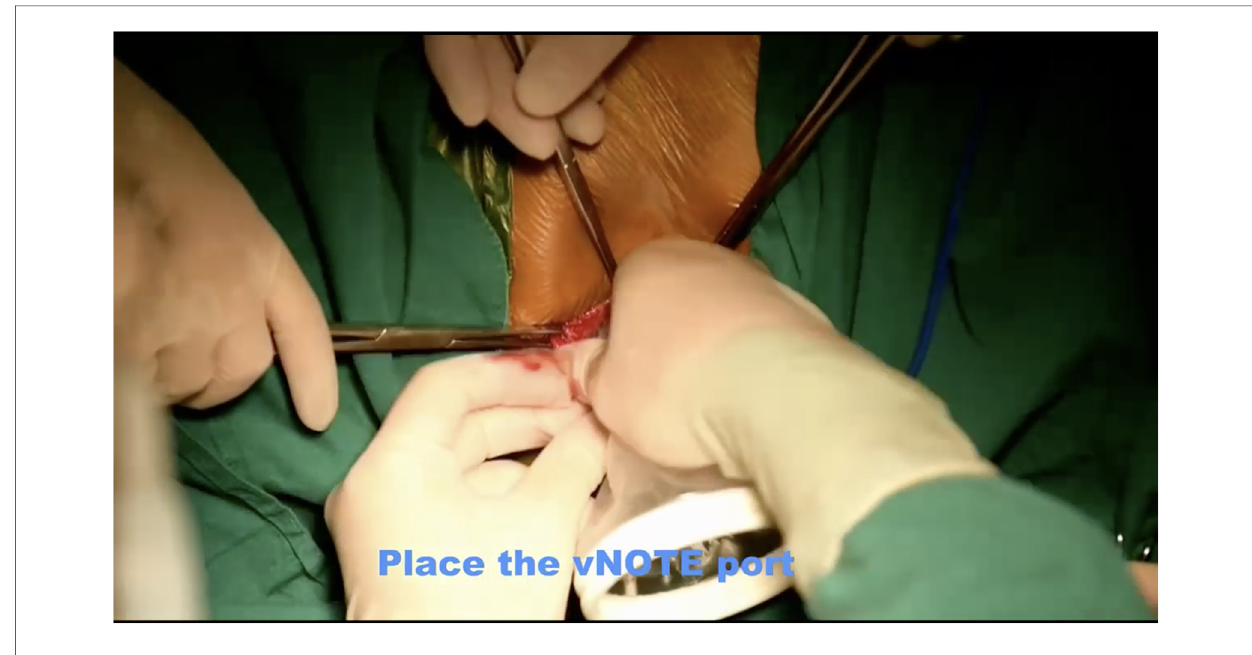
FIGURE 1 Placement of single-port devices. The laparoscopic incision protector was placed inside the posterior vaginal wall incision and made contact with the tissues..